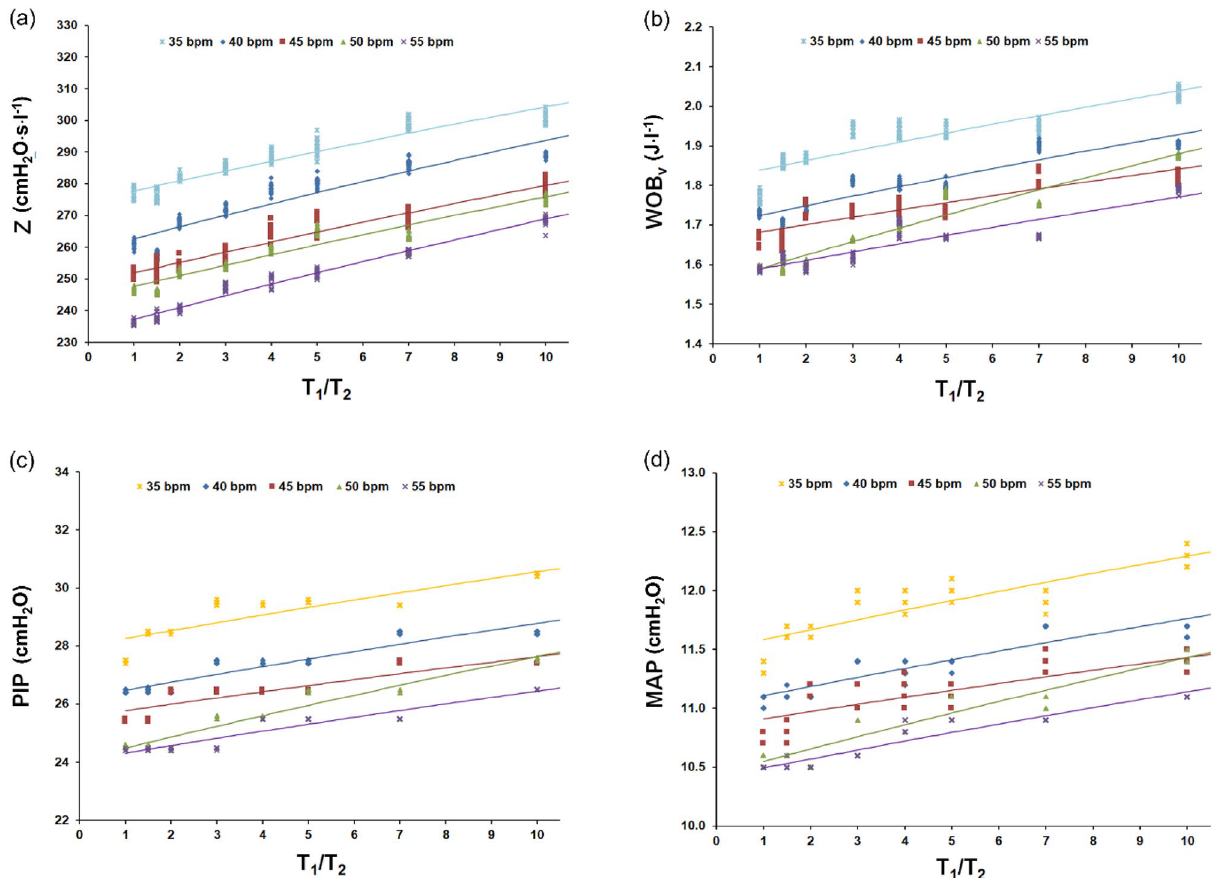
Figure 3. Respiratory system impedance (Z) in relation to VI degree (T 1 /T 2 ) ( a ), work of breathing (WOB vt ) vs T 1 /T 2 ( b ), peak inspiratory pressure (PIP) vs T 1 /T 2 ( c ), and mean airway pressure (MAP) vs T 1 /T 2 ( d ) for patient P 3 (R = 205 cmH 2 O·s/l; R C = 131 cmH 2 O·s/l, R 1 = R 2 = 88 cmH 2 O s/l; C = 1.14 ml/cmH 2 O; C w /C L =